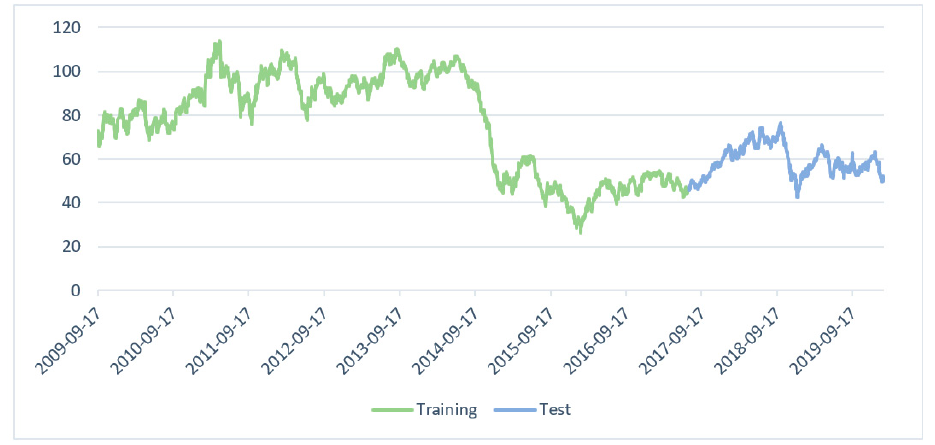
Figure 1. WTI crude oil futures prices for front-month delivery (in USD per barrel).